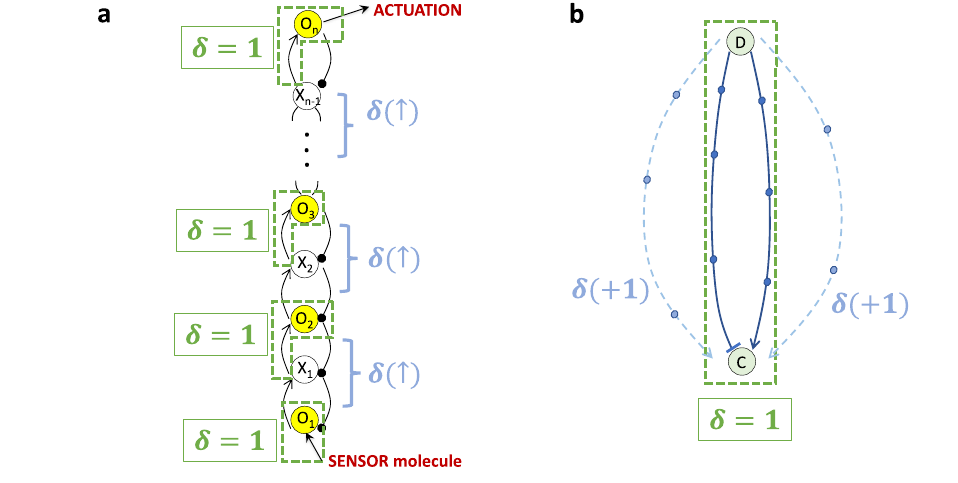
Fig. 6 | De fi ciency-increasing topological features of RPA-capable CRNs. a An opposing set, containing multiple interconnected feedback loops involving opposer nodes (indicated in yellow), all embedded together into the feedback segmentofanOpposermodule.Asshown,eachsingleopposercyclecontributesa de fi ciency of one to the CRN. The interspersed feedback loops that connect the individual opposer nodes further increase de fi ciency (SI Section S4.4.2), as